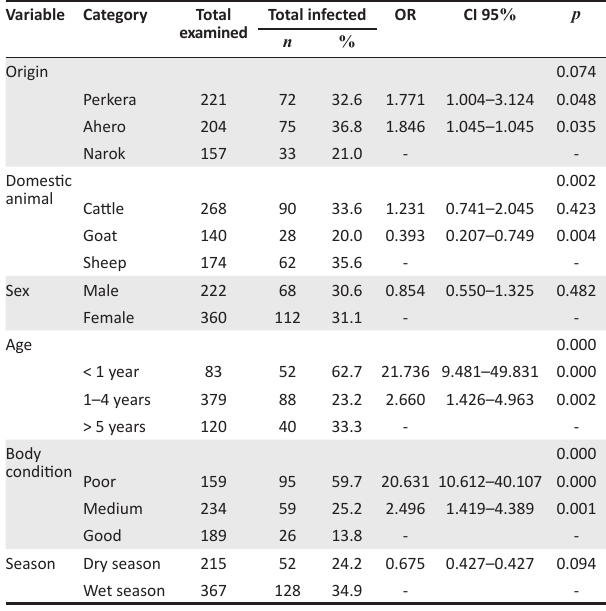
TABLE 2: Univariate logistic regression analysis of fasciolosis with associated risk factors. Variable